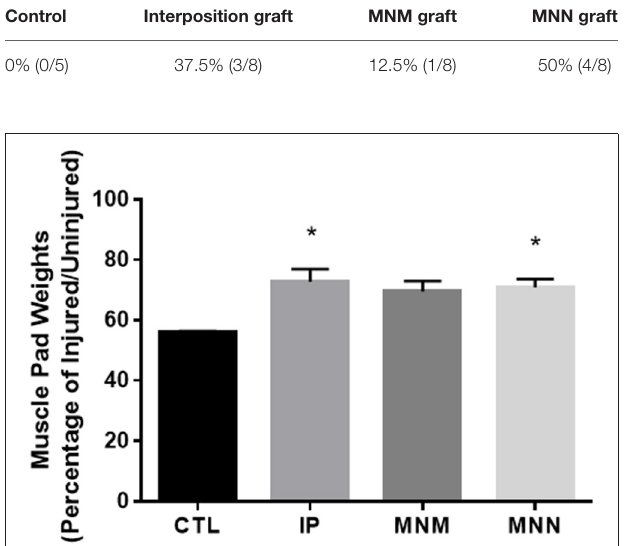
FIGURE 3 | Mean vibrissae muscle pad weight in each group. Muscle atrophy was determined by calculating the denervated muscle pad weight as standardized to that of the innervated muscle pad. Data represented as Mean ± SEM (* p <